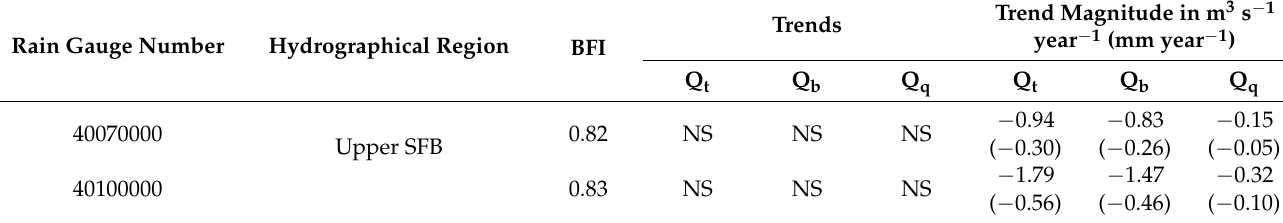
Table 2. The annual trend magnitude for the streamflow (Q t ), baseflow (Q b ) and quickflow (Q q ) in the Sao Francisco Basin (SFB) according to the river gauge. Trends were assessed using the Mann–Kendall and Theil–Sen’s slope estimator at 0.05 of the significance